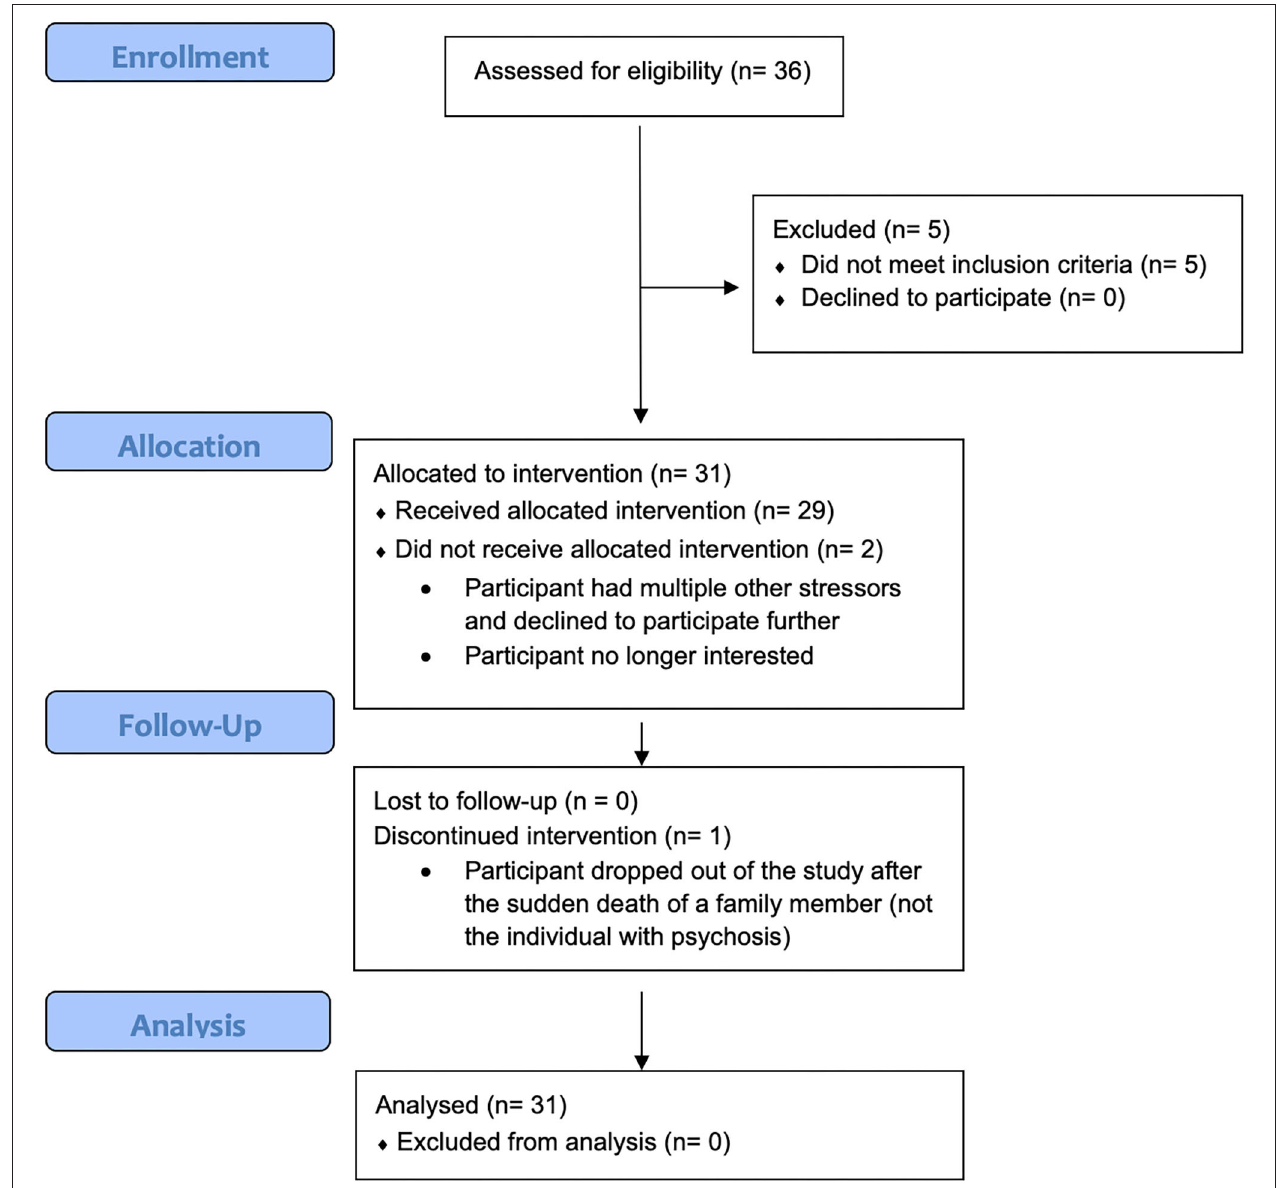
FIGURE 1 | CONSORT flow